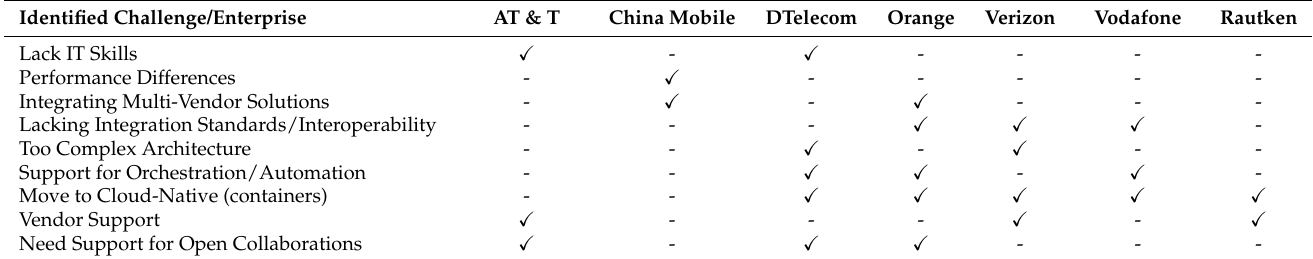
Table 6. Challenges of Network Function Virtualization NFV as identified by network operators in [120] survey that are relevant for virtualized PAC systems. (cid:88) = confirmed, - = not